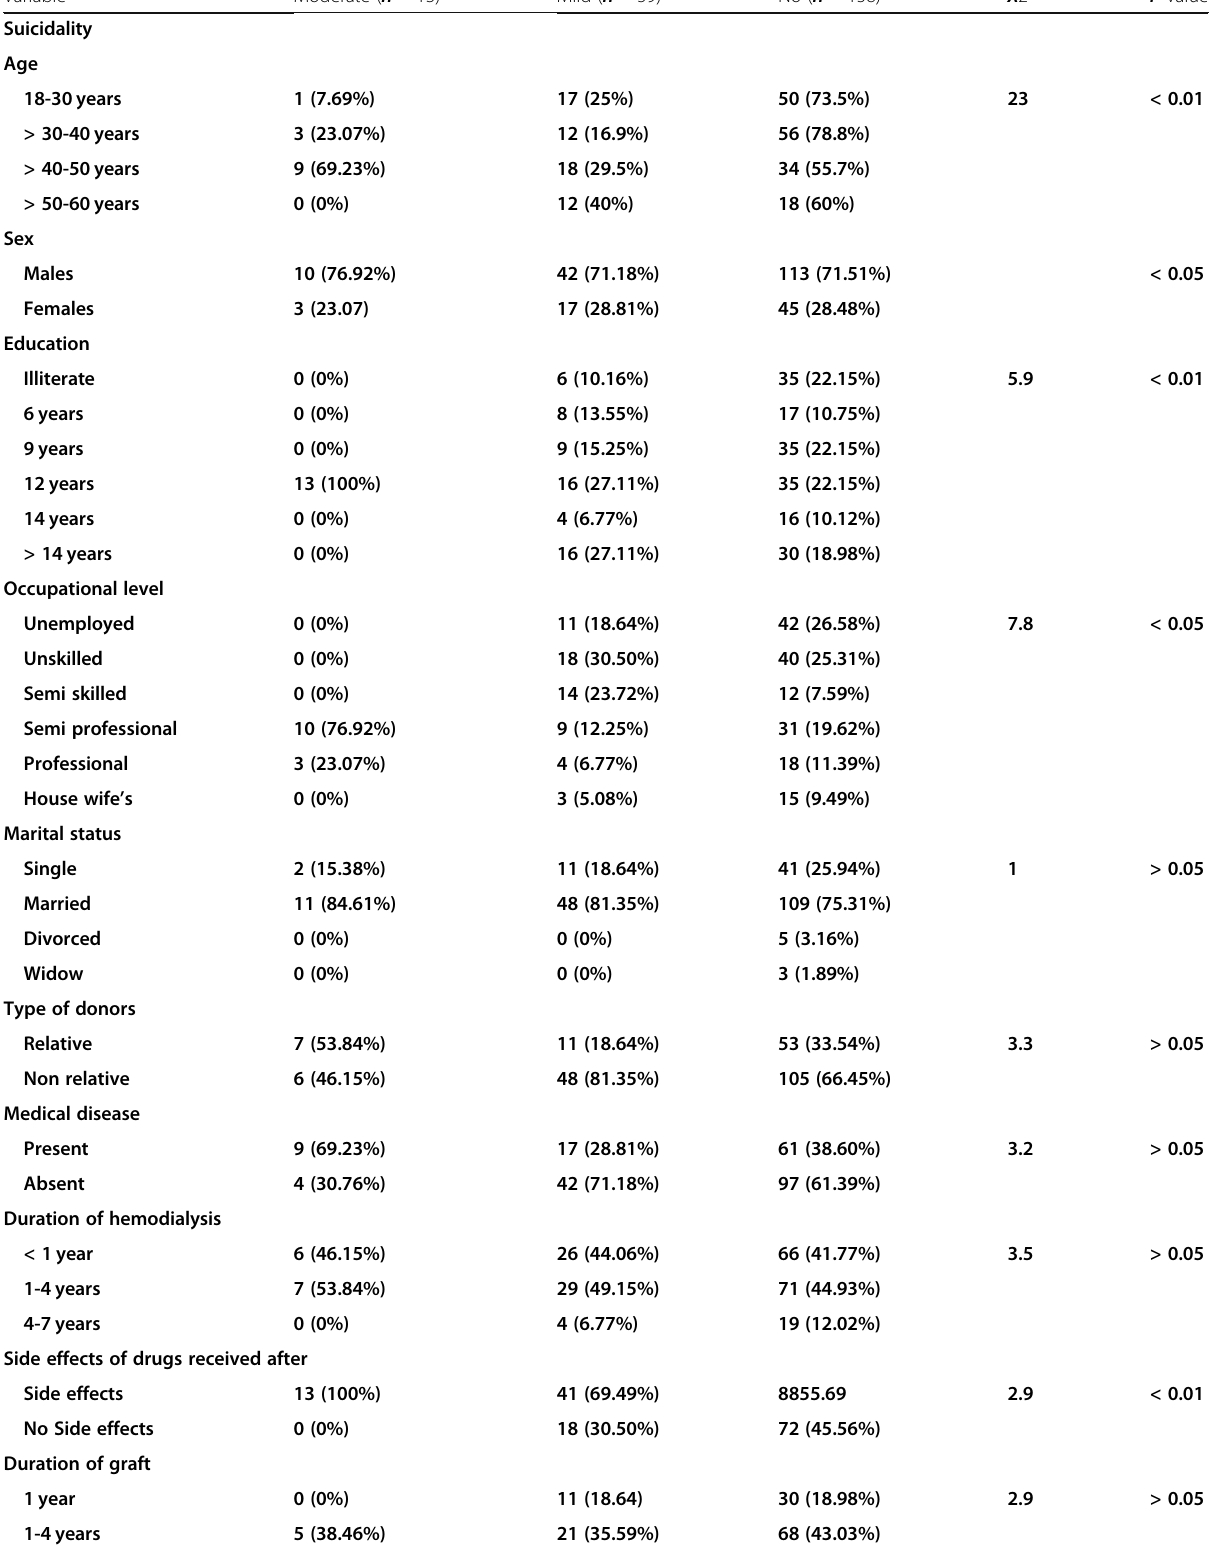
Table 2 Severity of suicidality risk in relation to sociodemographic and clinical variables in